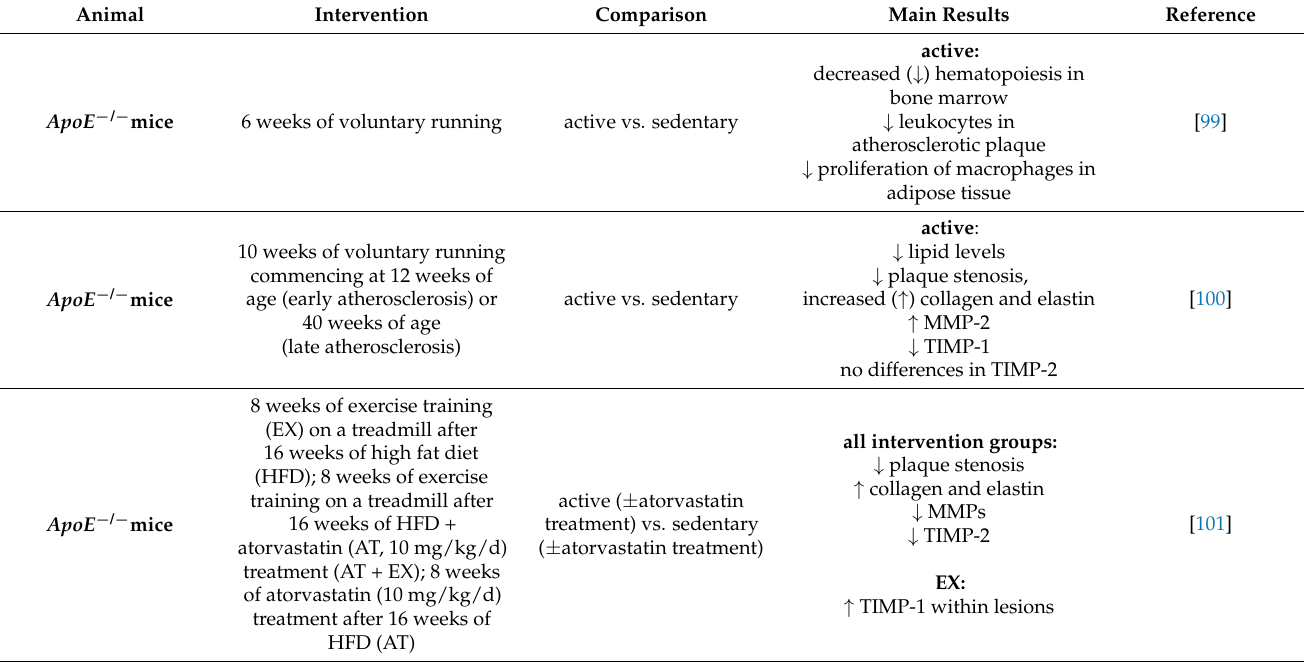
Table 2. Overview of animal trials cited in the